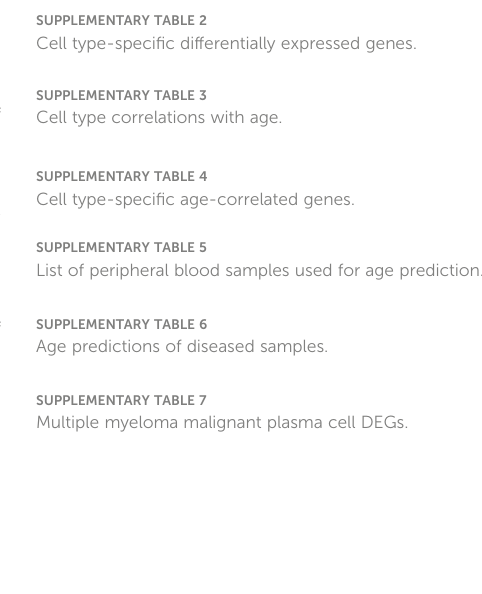
SUPPLEMENTARY TABLE 2 Cell type-speci fi c differentially expressed genes.